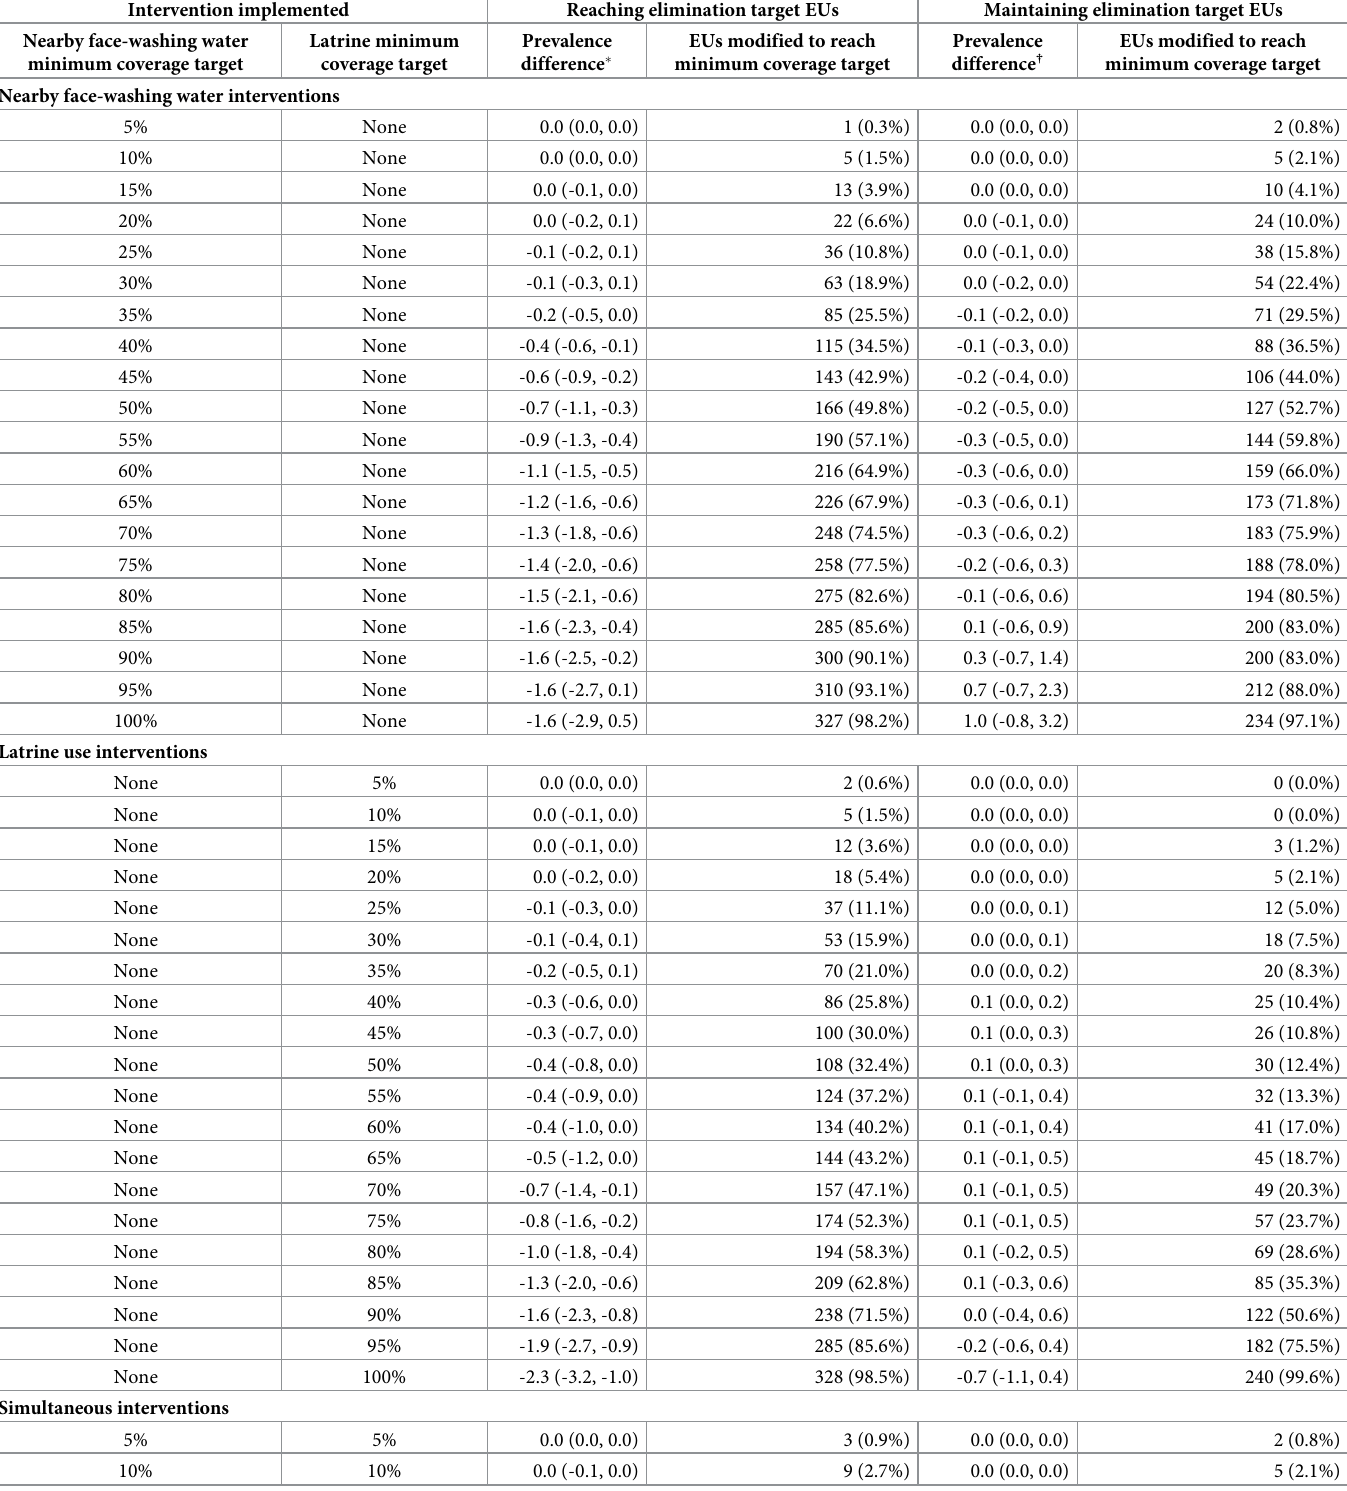
Table 2. TF 1-9 prevalence difference and number and percentage of EUs modified after implementing hypothetical interventions on nearby face-washing water and latrine